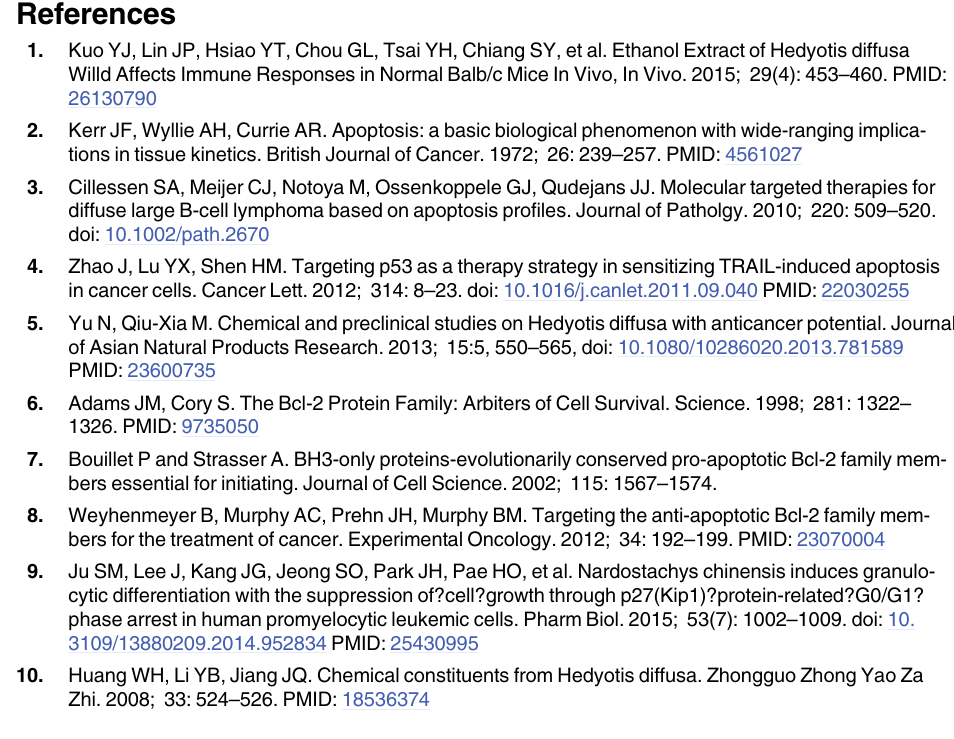
S1 Fig. Raw supplementary RT-PCR figure of bax in Fig 4E. S2 Fig. Raw supplementary RT-PCR figure of bcl-2 in Fig 4E. S3 Fig. Raw supplementary RT-PCR figure of p53 in Fig 4E. S4 Fig. Raw supplementary RT-PCR figure of beta in Fig